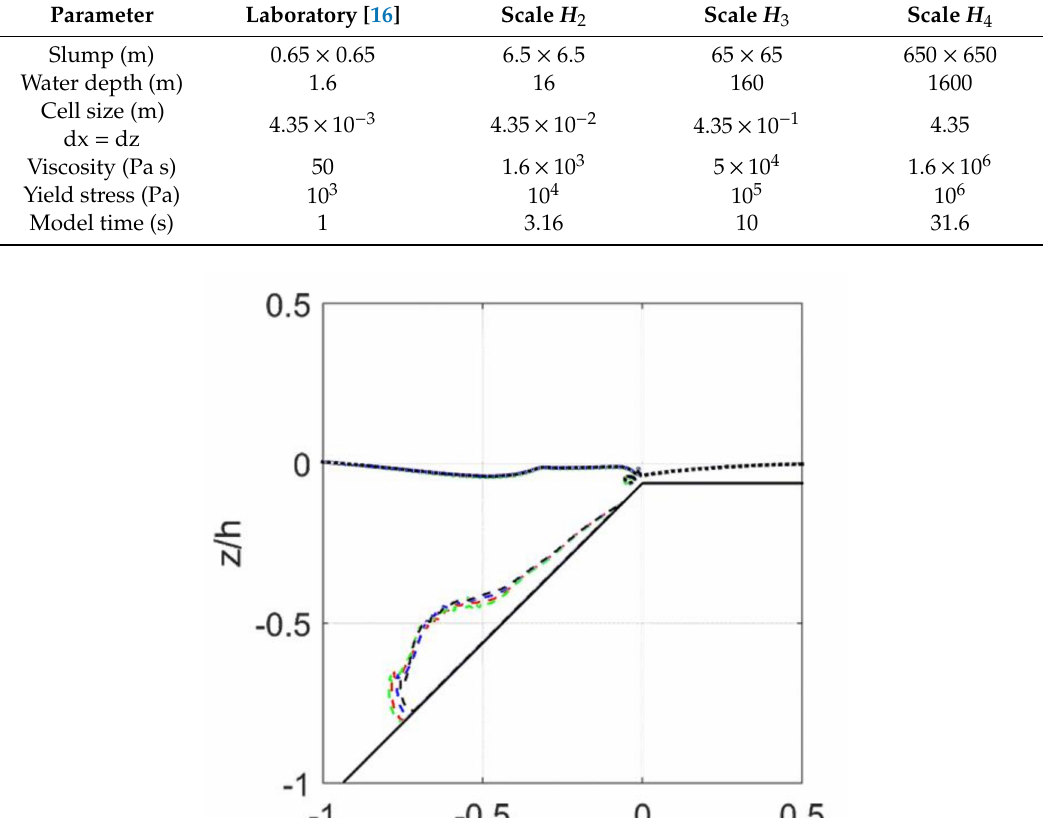
Table 1. The parameters for laboratory scales and field scales.